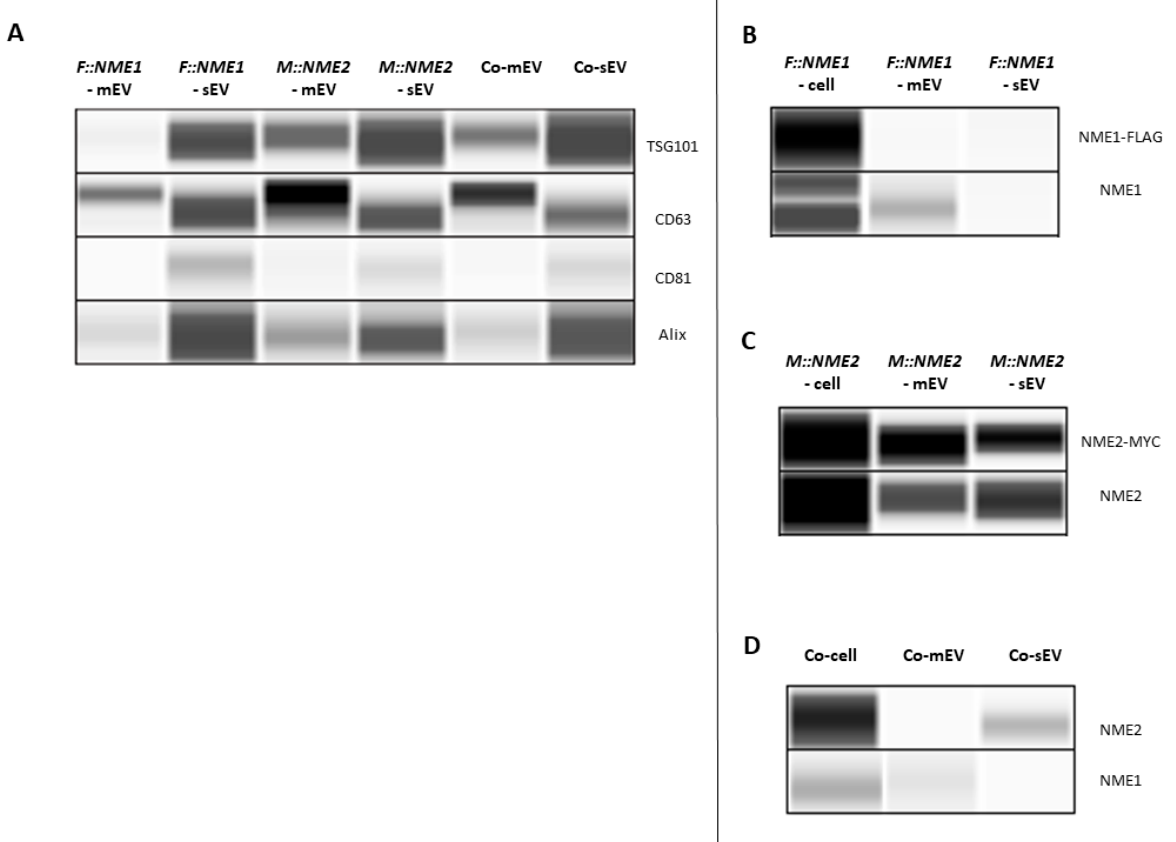
Figure 1. Detection of NME1 and NME2 in extracellular vesicles (EVs) derived from supernatants of NME1 or NME2 overexpressing, and control vector expressing MDA-MB-231T cell lines with WES TM Simple. Abbreviations: F::NME1, M::NME2 and Co stand for protein or EV lysates from FLAG::NME1, MYC::NME2 and control vector-transfected cells, respectively. Small- and medium-size extracellular vesicles are abbreviated as sEV and mEV, respectively. ( A ) Vesicle marker detection in EV lysates. TSG101 content of sEV fraction was higher than that of the mEV fraction. The enrichment of CD63 was observed in both isolated sEV and mEV fractions. CD81 and Alix were predominantly present in sEVs. ( B – D ) Detection of NME1 and NME2 proteins in cell and EV lysates. ( B , D ) NME1 protein was present in cell extracts and mEV fractions of ( B ) FLAG::NME1, and ( D ) the control vector-transfected cells. ( B , D ) In sEVs NME1 was not detectable by either antibodies. ( C , D ) NME2 protein was detected in cell extracts and ( C ) in both mEV and sEV fractions of the MYC::NME2 expressing cell line by using anti-MYC and NME2 specific antibodies.